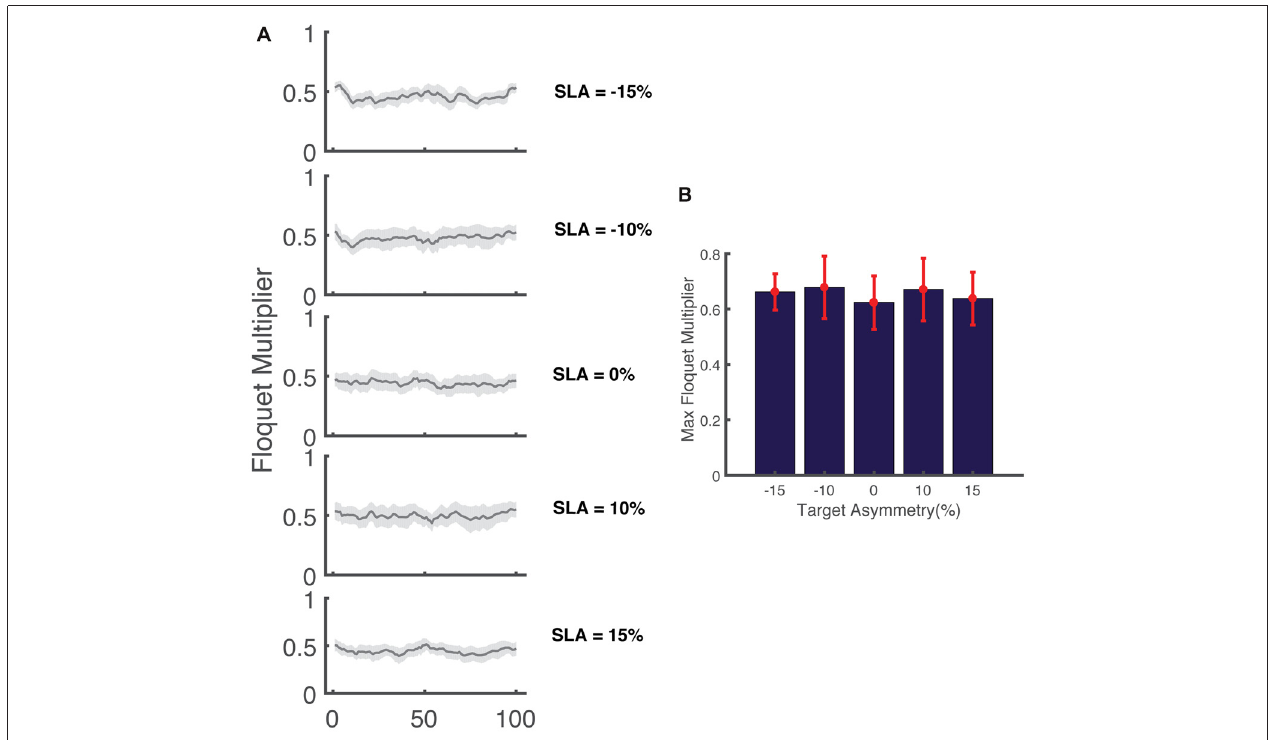
FIGURE 7 | (A) Variation in the magnitude of the maximum Floquet multiplier (FM) across the gait cycle for five levels of target asymmetry ( N = 17). The shaded area indicates the 95% confidence interval. (B) FM Max across all levels of asymmetry for ( N = 17)